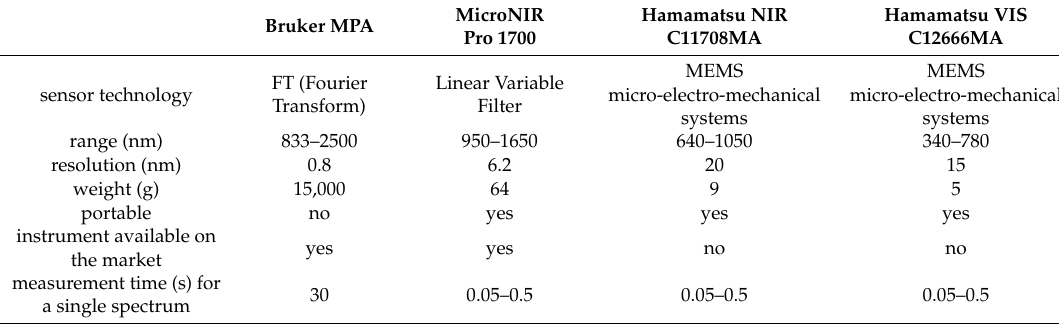
Table 1. Basic characteristic of tested spectrometers.